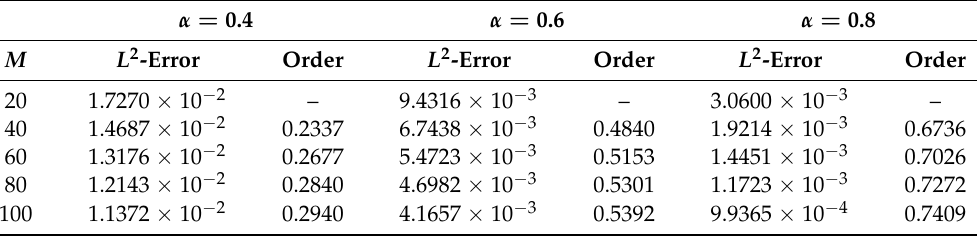
Table 1. The L 2 -norm errors and temporal convergence orders for Example 1 using scheme (18), M = N x = N y , k = 1, T = 1/4, r = 1.